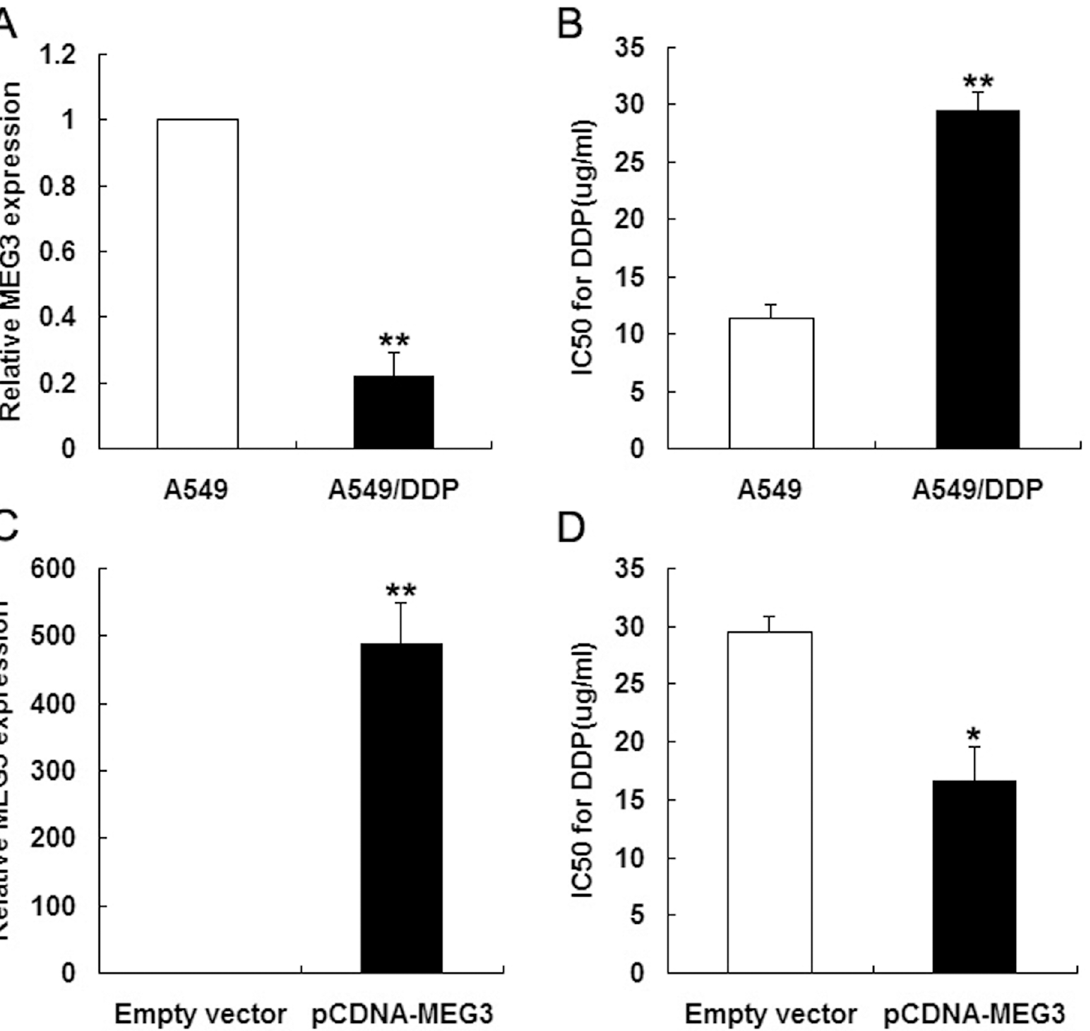
Fig 1. The level of MEG3 expression level in LAD cells. (Fig 1A) qRT-PCR analysis of MEG3 expression levels in A549 and A549/DDP cells. (Fig 1B) MTT assay of the IC 50 values of A549 and A549/DDP cells to cisplatin. (Fig 1C) qRT-PCR analysis of MEG3 expression levels following the transfection of A549/DDP cells with empty vector or pCDNA- MEG3 . (Fig 1D) MTT assay of the IC 50 values of empty vector- and pCDNA- MEG3 -transfected A549/DDP cells to cisplatin. * P < 0.05, ** P <